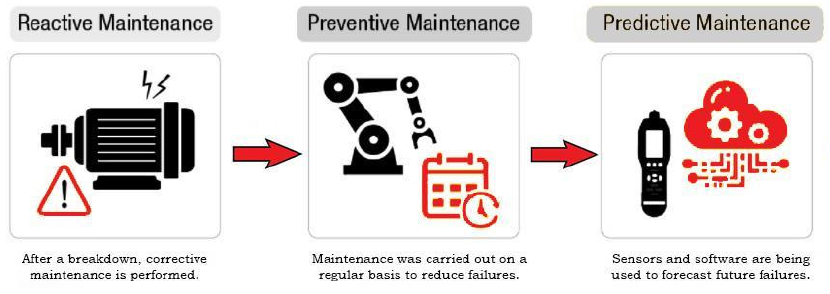
Figure 1. Evolution of maintenance.